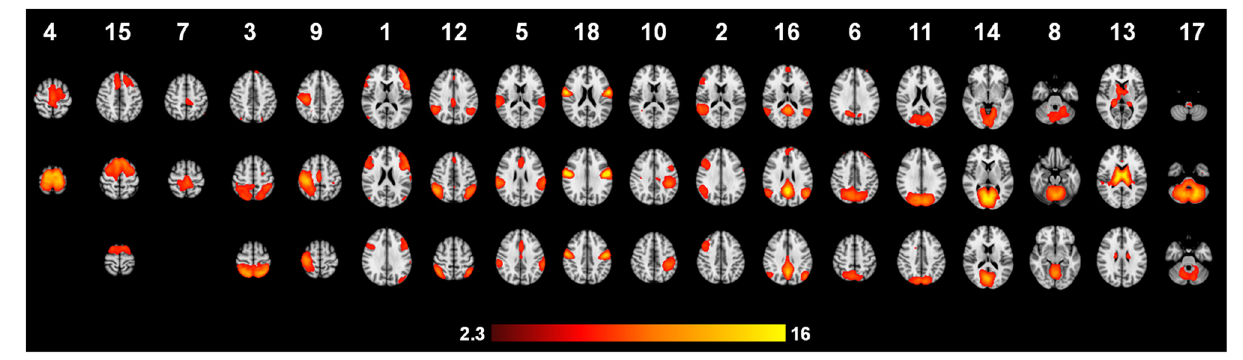
FIGURE 4 | Independent component maps with a clear neuroanatomical